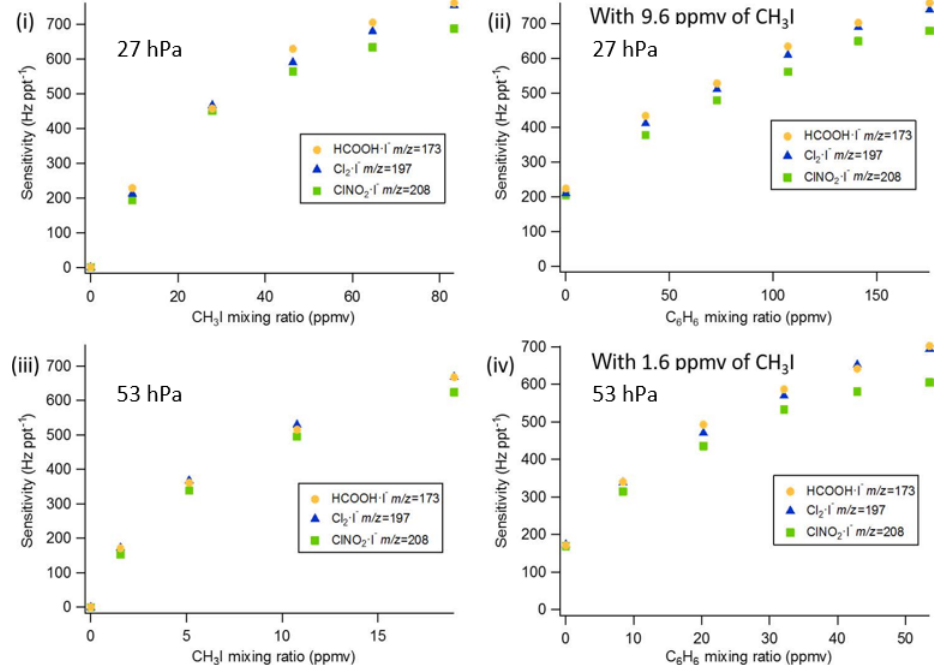
Figure 4. Q-CIMS using VUV-IS configuration (a): (i) sensitivity as a function of CH 3 I at 27hPa, (ii) sensitivity as a function of C 6 H 6 at 27hPa with 9.6ppmv of CH 3 I, (iii) sensitivity as a function of CH 3 I at 53hPa, and (iv) sensitivity as a function of C 6 H 6 at 53hPa with 1.6ppmv of CH 3